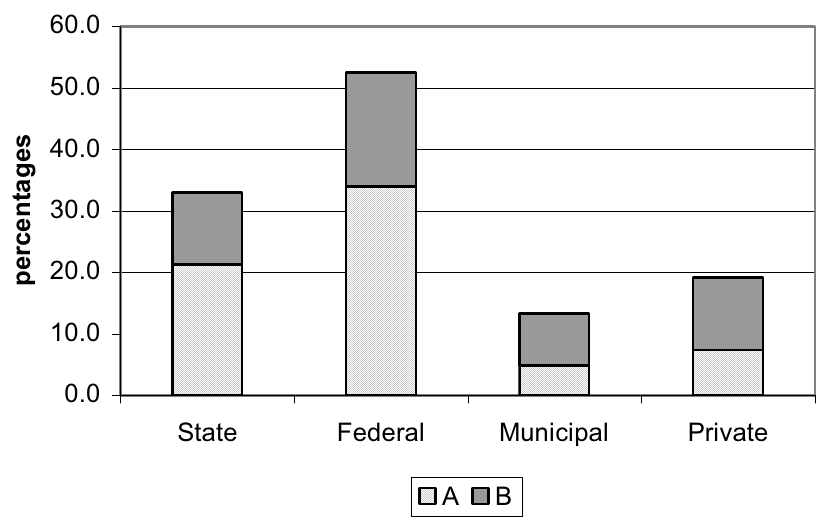
Fig. 3 – Percentage of A and B courses, by type of institution. Source: tabulated from the National Course Exam data set, provided by the Ministério da Educação.